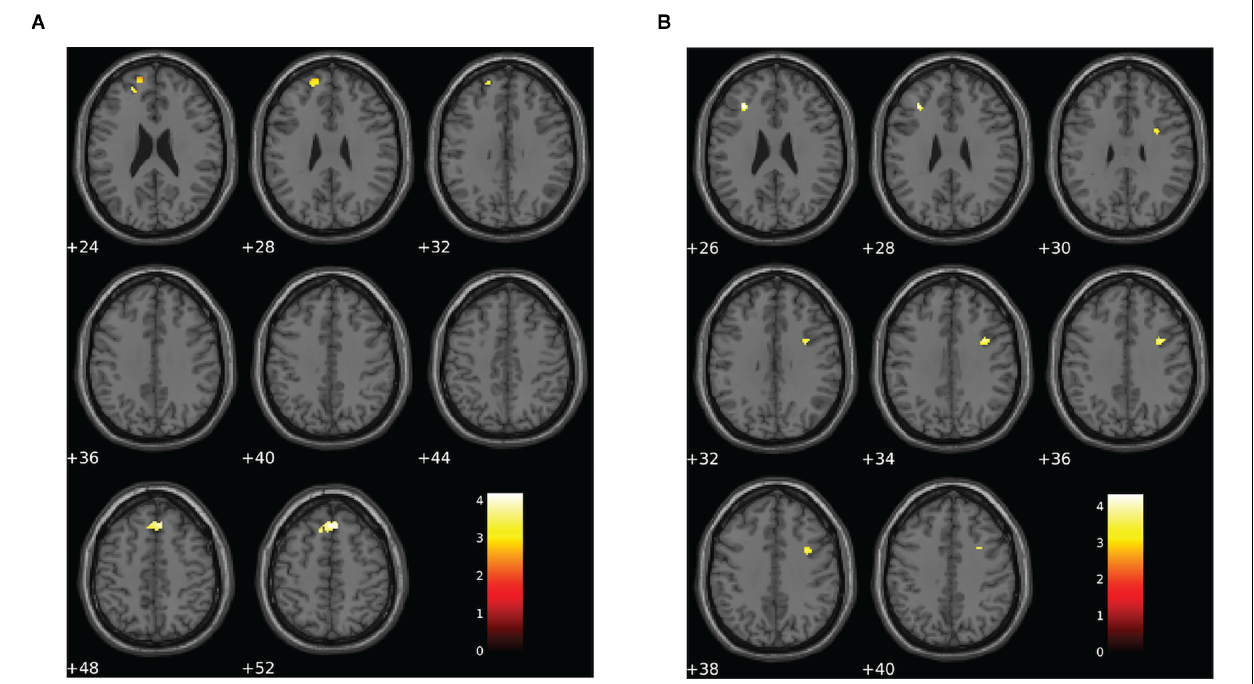
FIGURE 4 | Group differences for patterns of BOLD signal for the visual N-back task. (A) The choking group exhibited two clusters of increased BOLD signal for the contrast between the 1-back and 0-back conditions compared to the choking-naïve group. (B) The opposite pattern was observed for the contrast between the 2-back and 1-back conditions, such that the choking-naïve group exhibited increased activation in two clusters relative to the choking group. There were no significant differences between groups for the patterns of BOLD signal for the contrast between the 2-back and 0-back conditions for the visual N-back task. Statistical non-parametric maps were thresholded at p = 0.001 (uncorrected) and k ≥